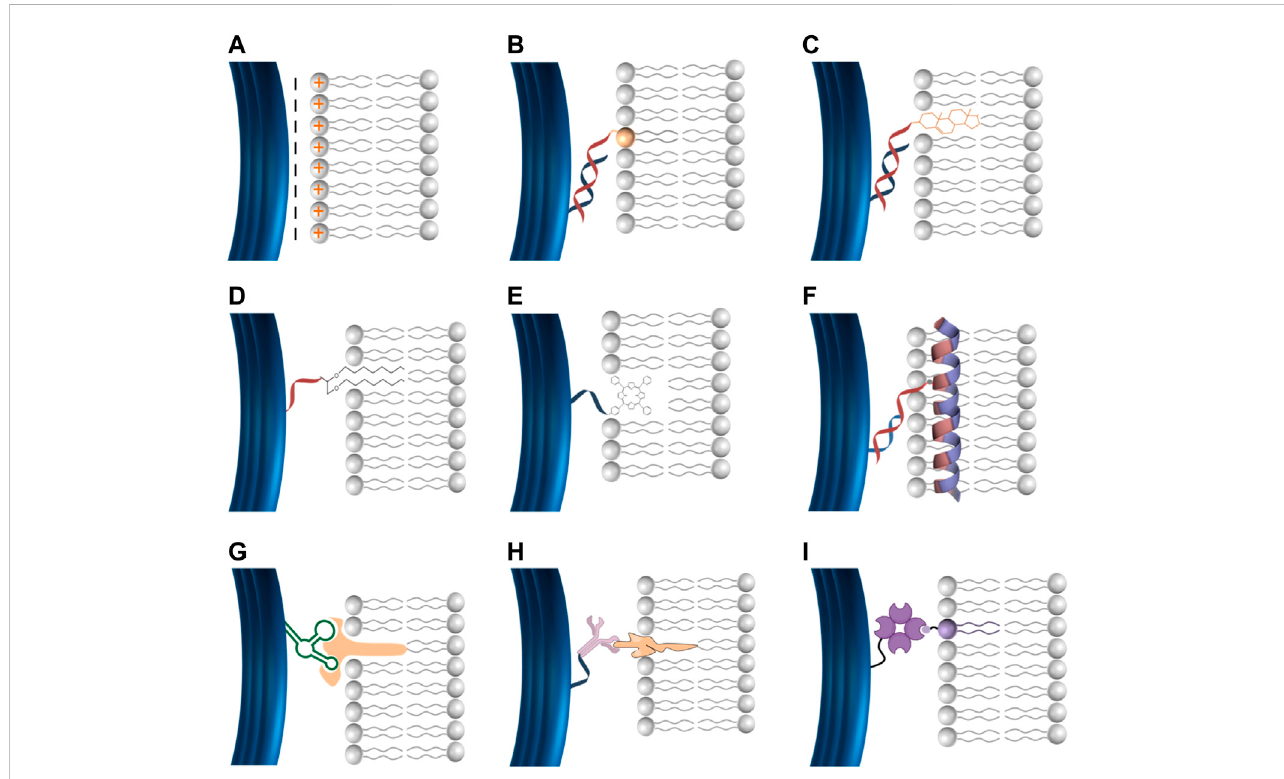
FIGURE 2 DNA lipid-bilayer membranes conjugation methods. (A) DNA can electrostatically bind to cationic lipid bilayers. DNA can bind to lipid bilayers via hydrophobic moieties, including phospholipids (B) , cholesterol (C) , ethyl – thiol groups (D) , and porphyrin (E) . DNA can bind to lipid bilayers via amphipathic molecules such as the membrane scaffold proteins (MSPs) (F) . Speci fi c membrane-associated molecules for a ligand – receptor interaction, including aptamer – target (G) , antigen – antibody (H) , and biotin – streptavidin (I) can be used to facilitate the conjugation of DNA to lipid-bilayer